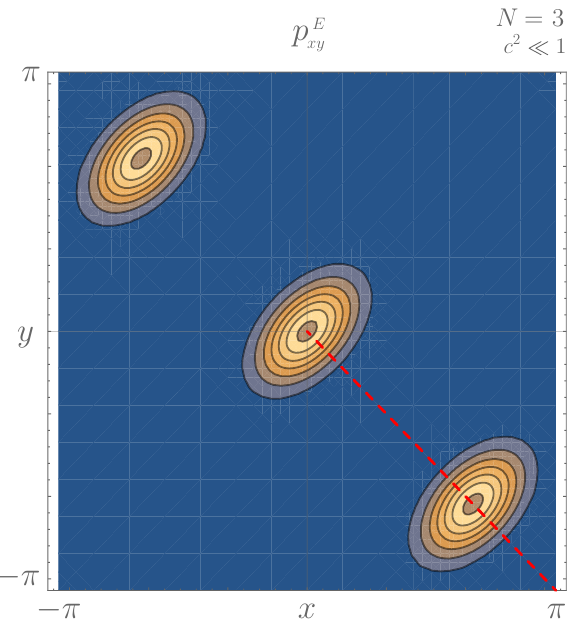
is presented. Notice that the structure of Gaussian peaks seen in Figure 7. A contour plot of p E xy all previous scenarios is also present but in a diagonal direction combining x and y . If we take the dashed line as an axis one gets figure